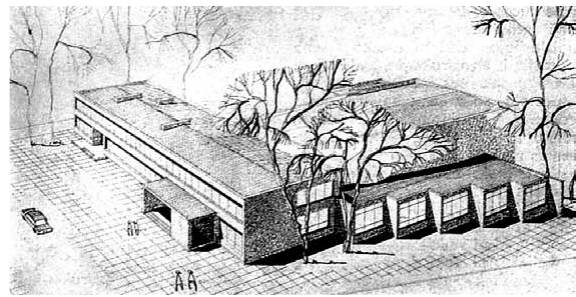
3 pav. netičkampio kultūros namai, 1968 m. Fig. 3. The House of Culture in netičkampis, 1968